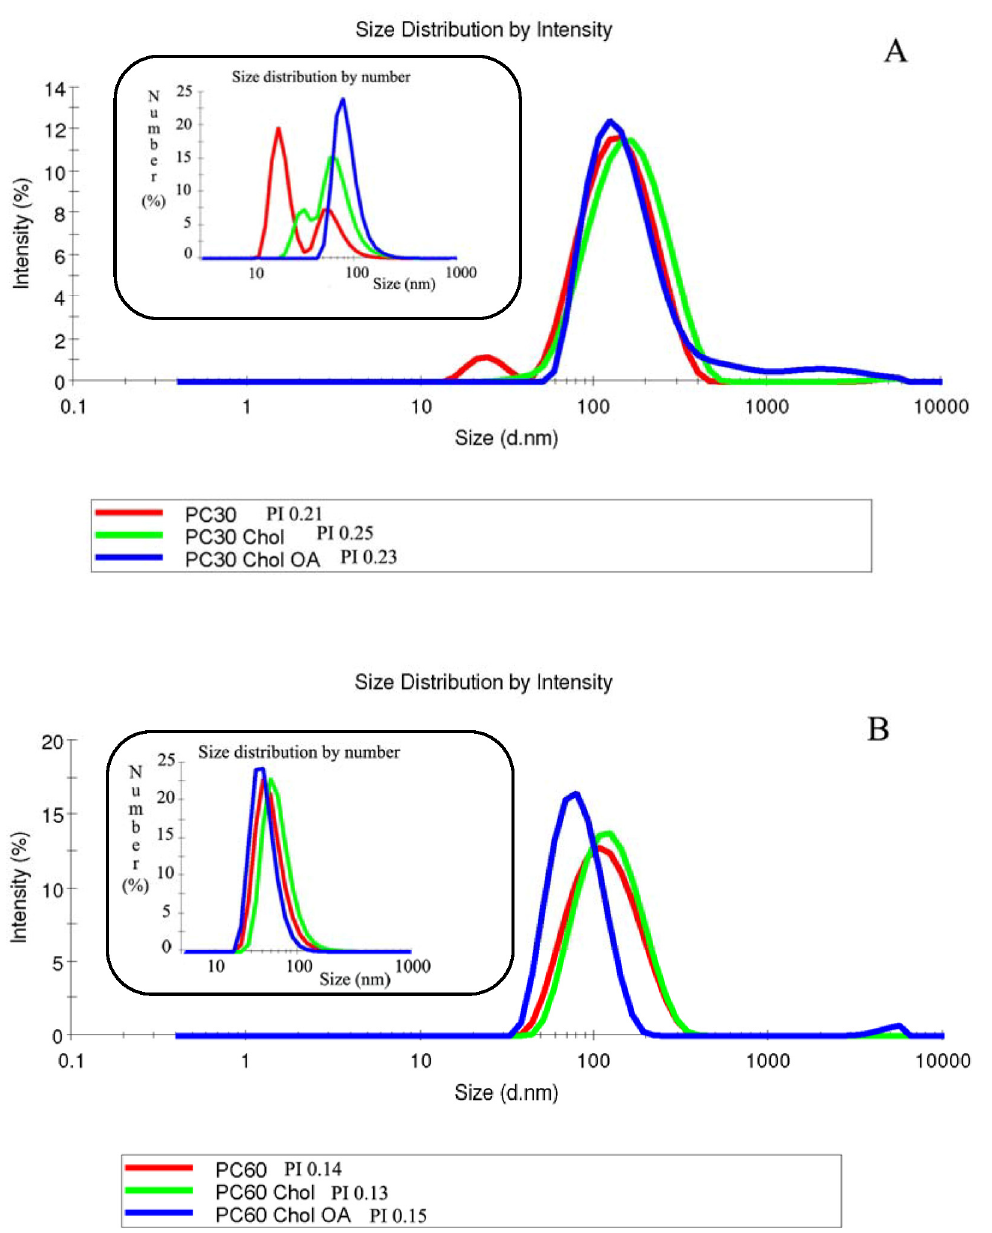
Figure 2. Size distribution curves of PC30 ( A ) and PC60 ( B ) samples as a function of intensity and number of vesicles, obtained from dynamic light